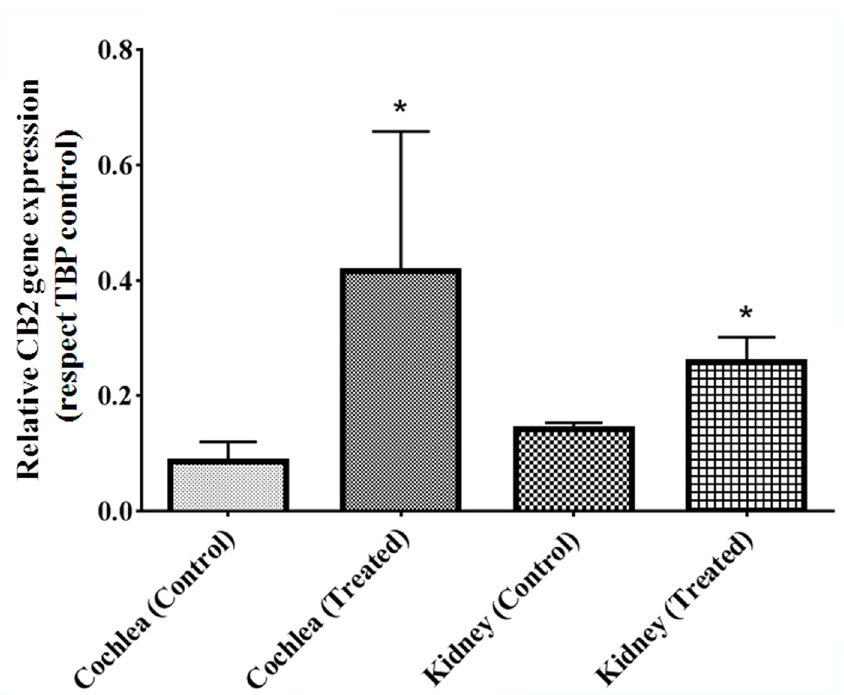
Fig 8. Measure of relative CB 2 gene expression by RT-qPCR. Measure of CB 2 gene expression in the cochlea and kidney of healthy (control) and CDDP treated animals, respect TBP reference. CB 2 gene expression was significantly higher in animals treated with CDDP than those in control group. The diagrams include the mean, the standard deviation (n = 10), and the ANOVA results (difference statistically significant respect control * p <